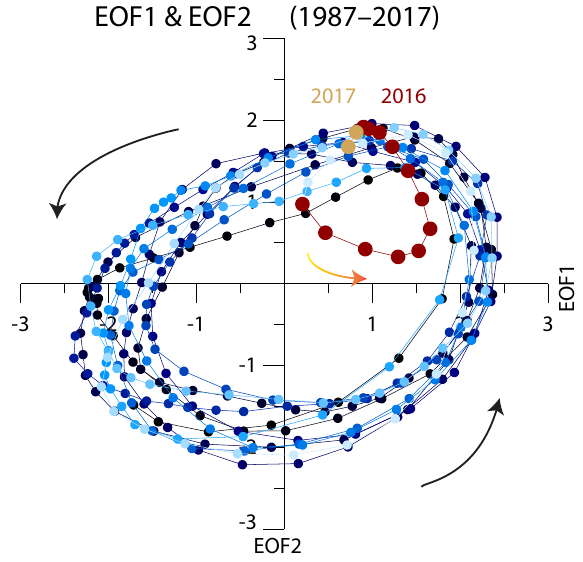
Figure 2. Phase space diagram of the projection of the monthly equatorial zonal wind anomalies onto spatial structures EOF1 and EOF2. Time progression coincides with counterclockwise orbit transits. Dots represent each month from January 1987 to February 2017. Different shades of blue indicate different years from 1987 to 2015 (from darker to lighter), while red and yellow dots correspond to 2016 and 2017,